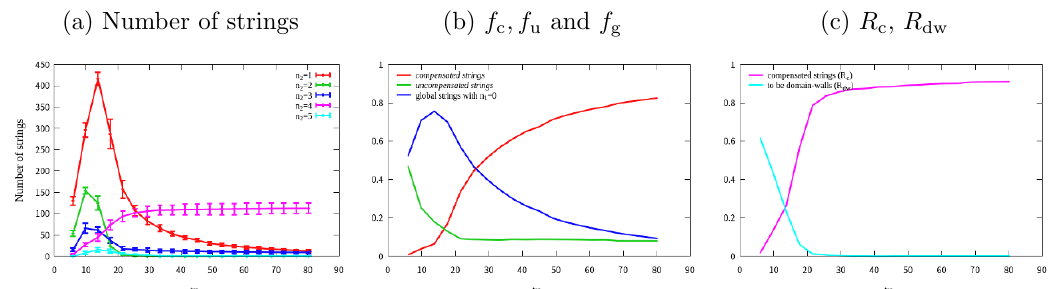
Figure 6. The same (cid:12)gures as that shown in (cid:12)gure 5 for the case including the thermal mass and ( q 1 ; q 2 ) = (1 ; 4).